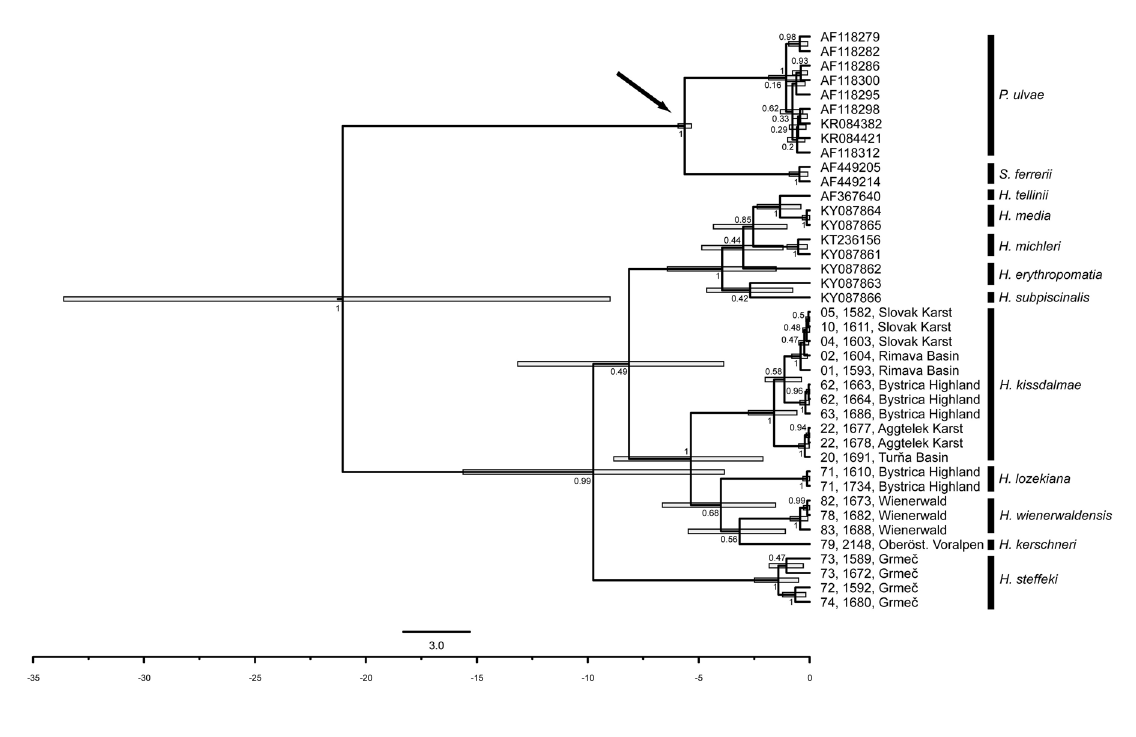
Fig. 9. Phylogenetic time-tree from Bayesian analysis in BEAST based on COI. Specimens identified by two-digit locality code in bold, four digit individual DNA code, and orographic unit (see Table 1) or GenBank accession number (from Wilke & Davis 2000; Wilke 2003; Ponder et al. 2008; Falniowski & Szarowska 2015; Barco et al. 2016; Rysiewska et al. 2017); posterior probabilities and highest posterior density intervals at nodes; arrow points at calibrated node; scale bar in substitutions per site; timeline on bottom in Ma before